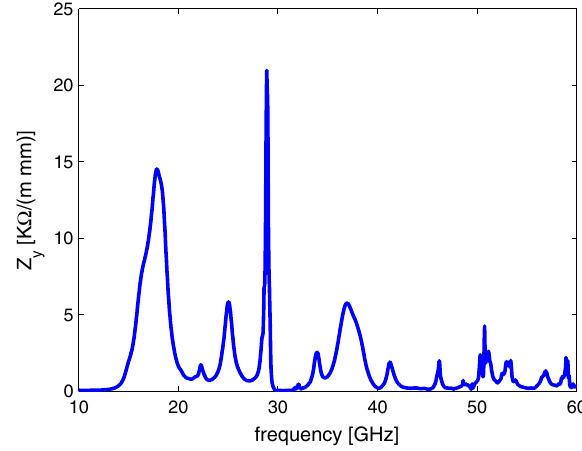
FIG. 6. Wakefield impedance spectrum of CDS-A.